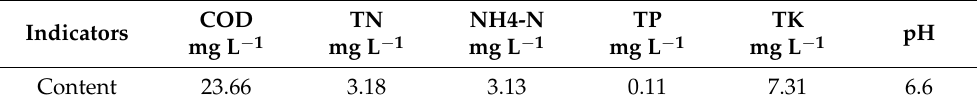
Table 3. The physical and chemical indicators of irrigation water (sampling date: 2019.04.25).